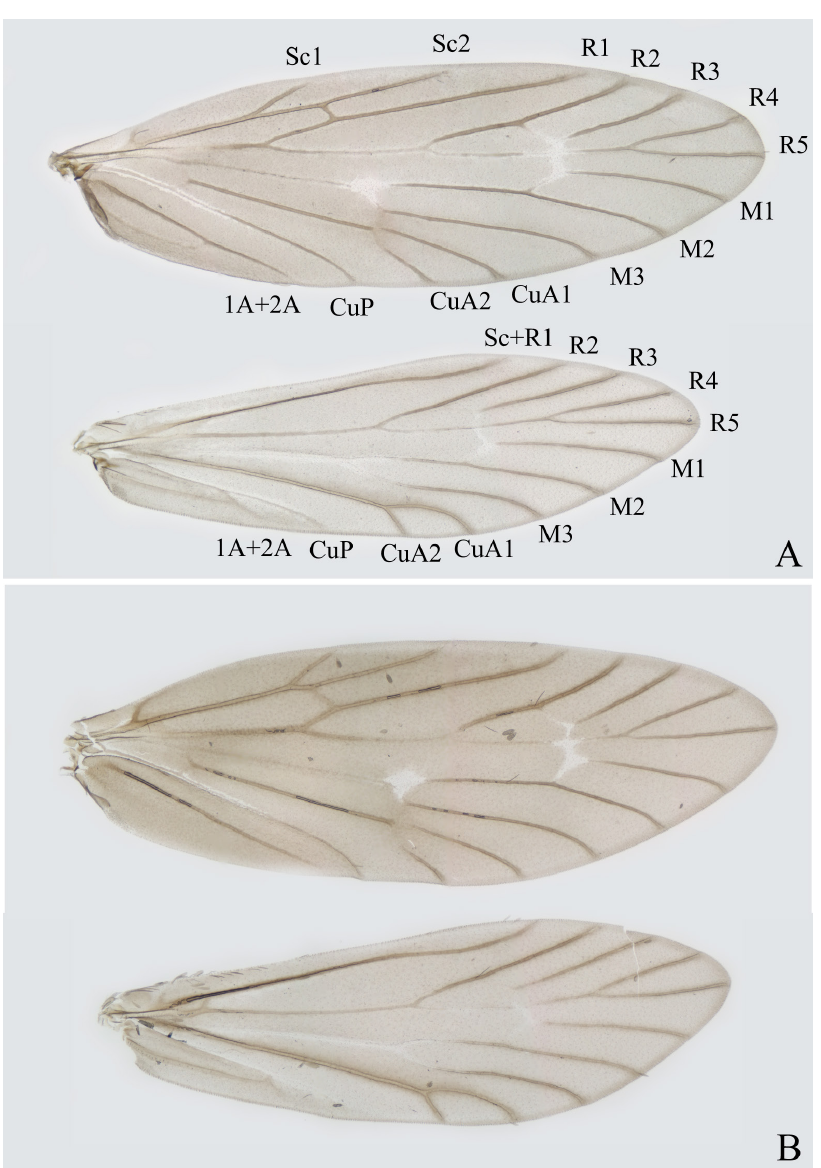
Fig. 2. Wing venation. A . Vietomartyria wuyunjiena sp. nov. ♀. B . V. maoershana sp. nov.